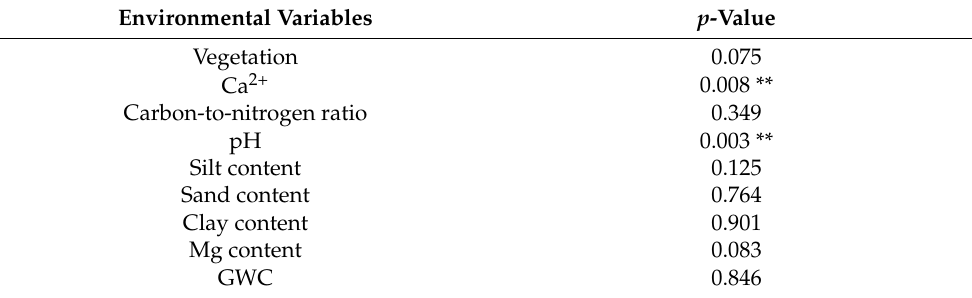
Table 5. PERMANOVA tests to analyse the influence of the selected abiotic factors on the distribution of the known DNA bacteriophage genera ( α =